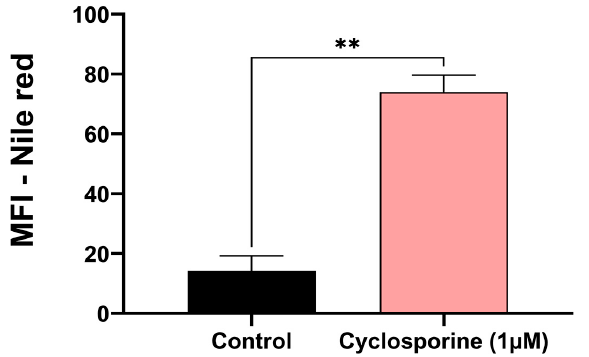
Figure 3. Analysis of the mean fluorescence intensity (MFI) of untreated C. neoformans cells and those treated with 1 µM of cyclosporine and stained with Nile red, a lipid body marker. Statistical significance was determined via a t-test (** p -value = 0.007).